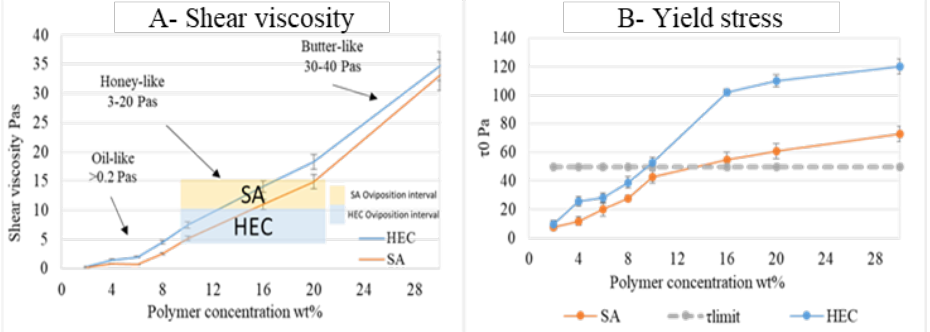
Figure 7. ( A ) Shear viscosity values ± SD for different HEC and SA concentrations (wt%) evaluated in a single shear rate test (50 s −1 ) at 25 °C in plate-plate configuration. ( B ) Yield stress values ± SD with polymer concentration evaluated in a shear rate range 0 – 100 s −1 at 25 °C with plate-plate configuration.